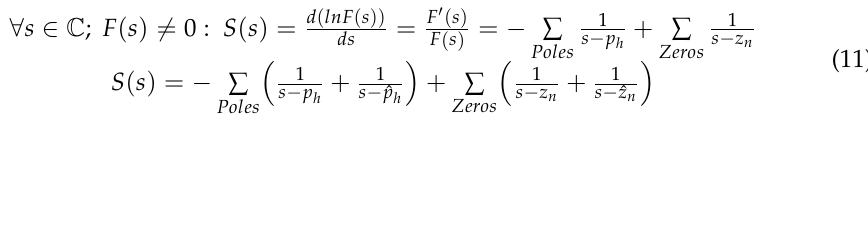
Figure 3. ( a ) Real component; ( b ) imaginary component; ( c ) absolute value of the 3D Diagrams of the three functions 𝐺 , 𝜁 , and 𝐹 .